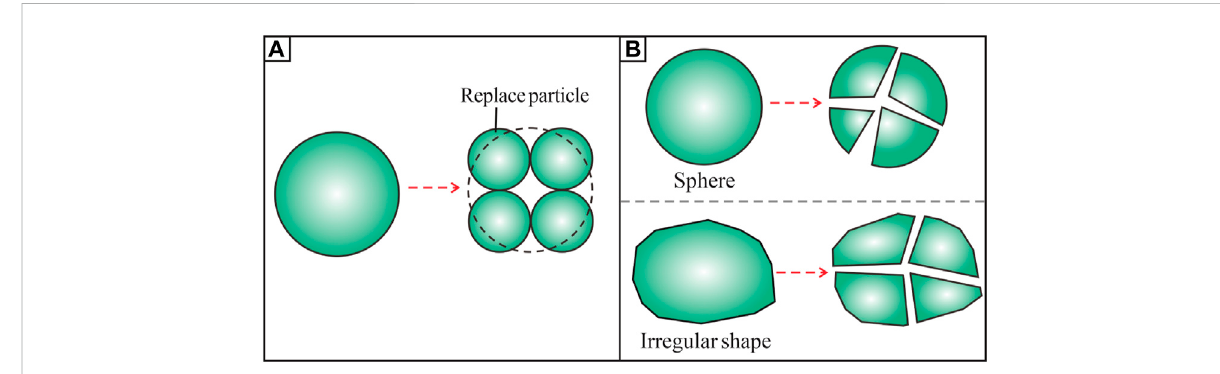
FIGURE 10 Comparison of DEM simulation methods for particle breakage: (A) particle replacement method and (B) particle cutting method.